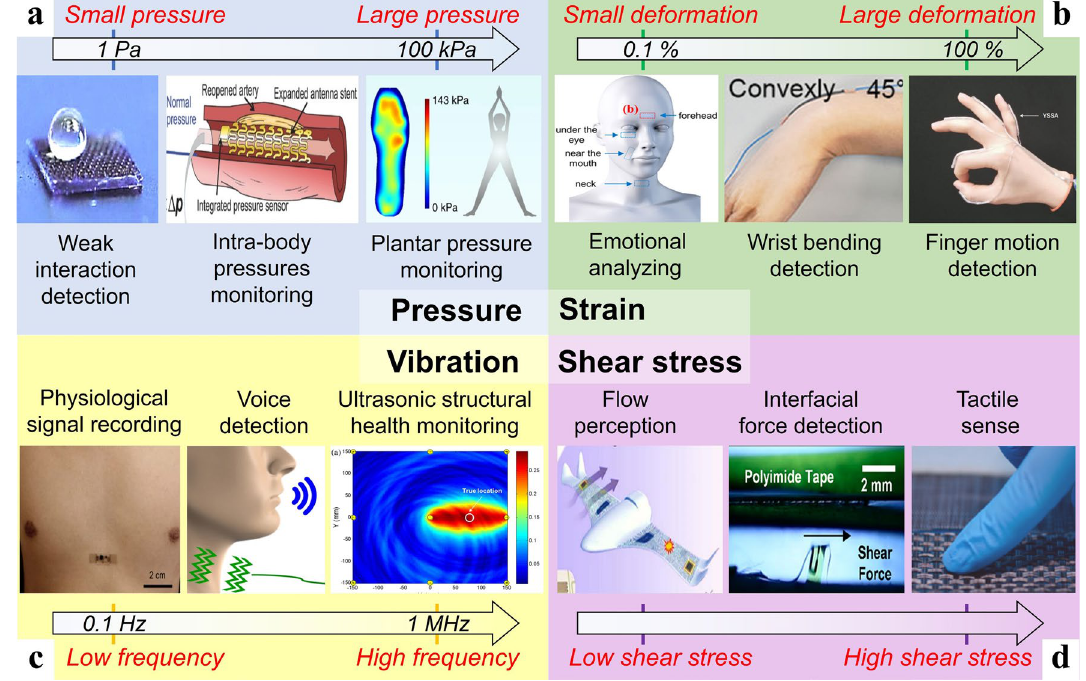
Fig. 3 Common applications of four types of flexible mechanical sensing including a pressure sensing [91–93] (Copyright (2017) The Authors, Copyright (2020) The Authors, Copyright (2020) The Authors), b strain sensing [23, 94, 95] (Copyright (2015) American Chemical